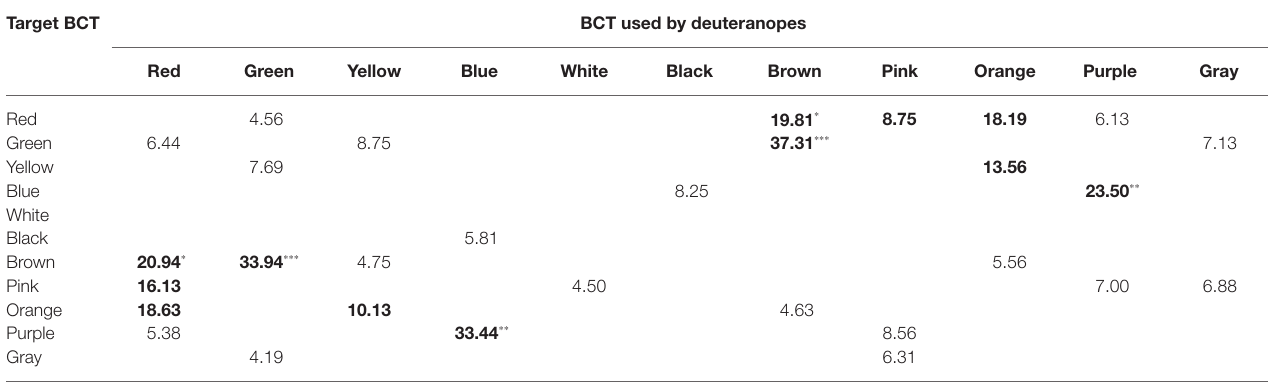
TABLE 4 | Deuteranope confusion matrix obtained in the verbal task. Target BCT BCT used by